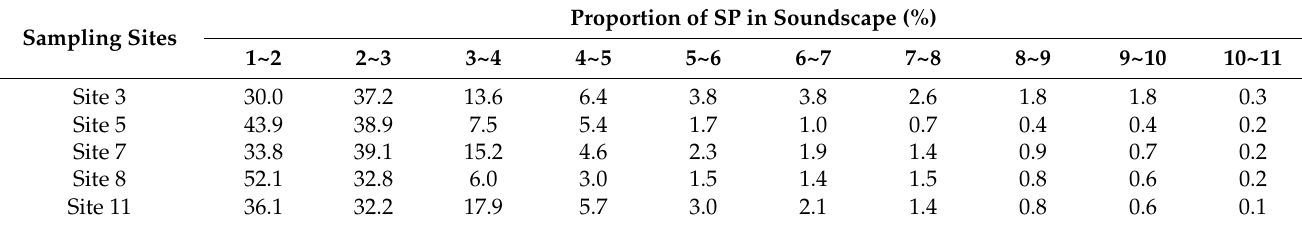
Figure 5. Soundscape power for each of 10 frequency intervals (1–11 kHz) computed from acoustic sensors in five sampling sites. Soundscape compositions of 5 sampling sites are similar, frequency of birdsong is mainly in range 2–8 kHz, as indicated by the red rectangle. Table 3. Percentage of total soundscape power for each of 10 frequency intervals (1–11 kHz) computed from sound recordings at five sampling sites, the unit of frequency is kHz.